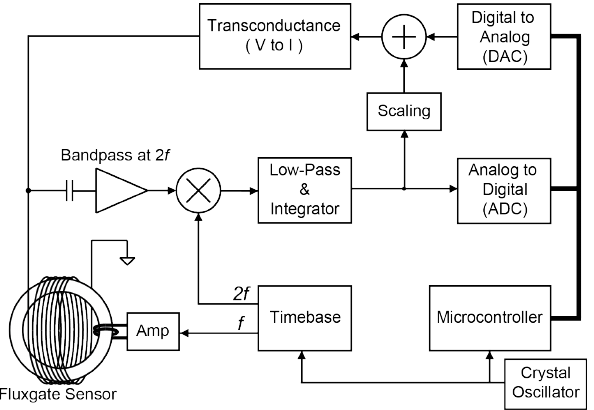
Figure 7. Single channel block diagram of the fluxgate magnetome- ter. Adapted from Wallis et al.